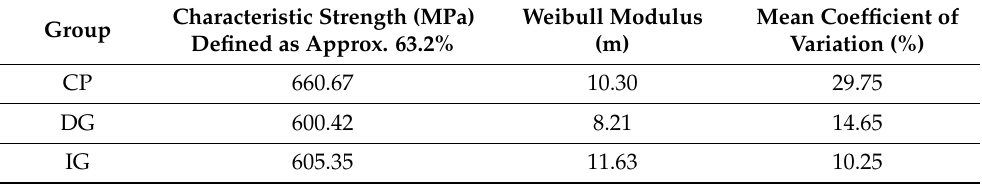
Figure 8. Weibull plot for flexural strength of group CP, DG and IG. Table 7. Table showing characteristic strength (calculated failure stress), Weibull modulus and mean coefficient of variation of group CP, DG and IG groups. Note the control group shows the highest characteristic strength.